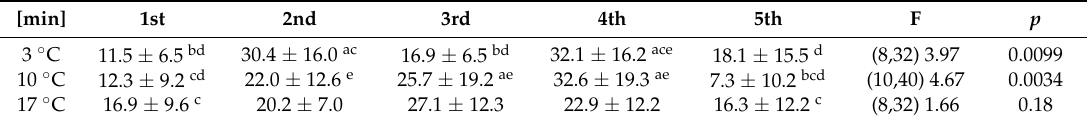
Table 2. Duration of the REM period of the sleep cycle at 3 ◦ C, 10 ◦ C and 17 ◦ C. Results are shown as the average ± SD in